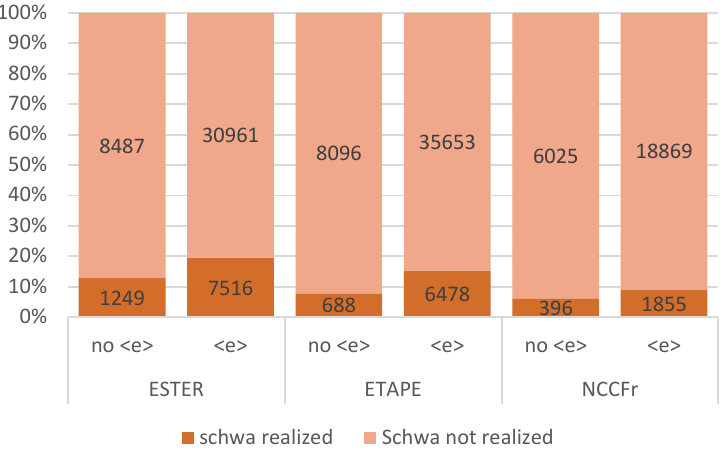
Figure 2. Realization of word-final schwa as a function of orthography by